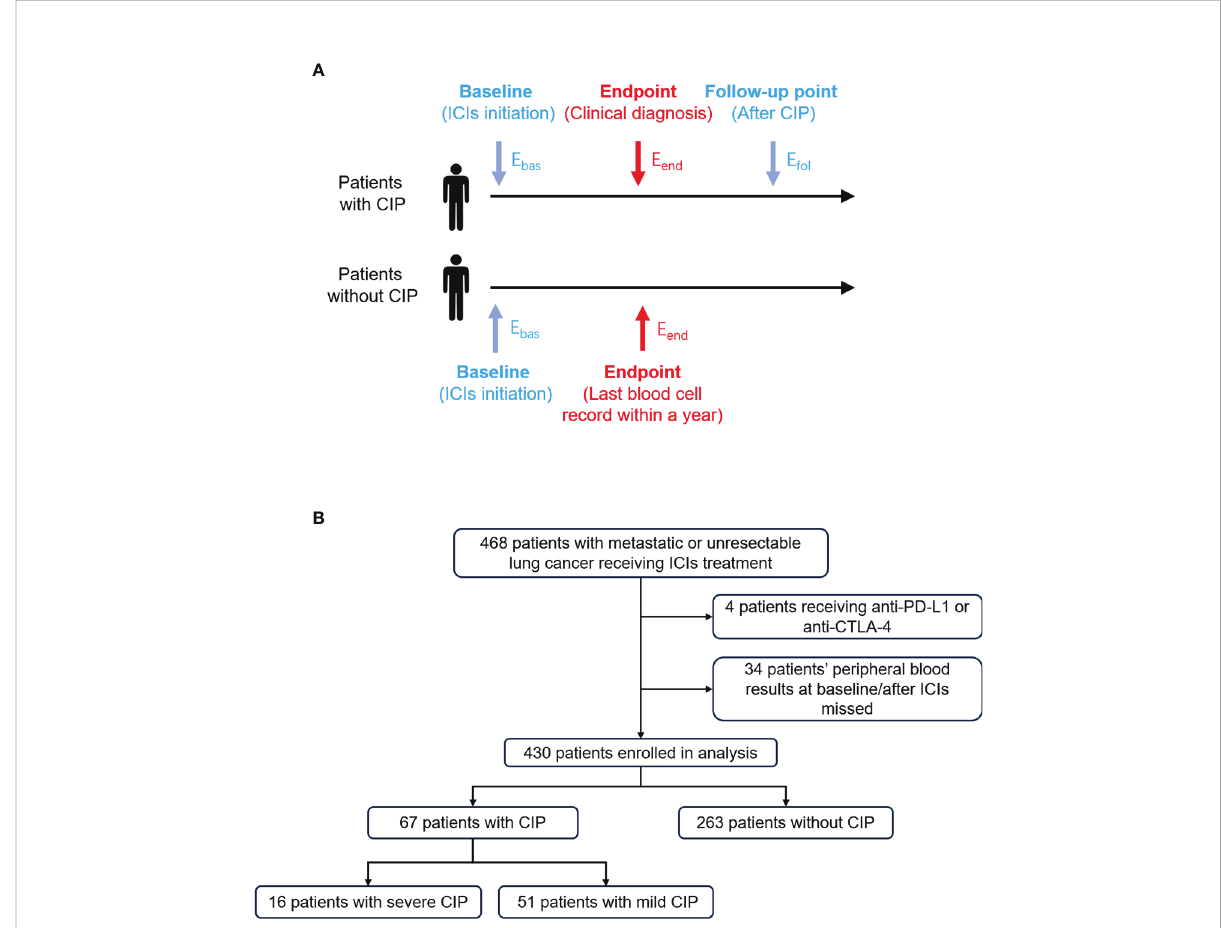
FIGURE 1 Study design and fl ow chart for patient selection. (A) Eosinophil percentage at different timepoints were extracted and de fi ned in patients with or without CIP. The longest follow-up time for CIP was 1 year. E bas , E end , and E fol represented eosinophil percentage at baseline, endpoint, and follow- up point, respectively. (B) The process of patient enrollment for analysis. CIP, checkpoint inhibitor pneumonitis; ICIs, immune checkpoint